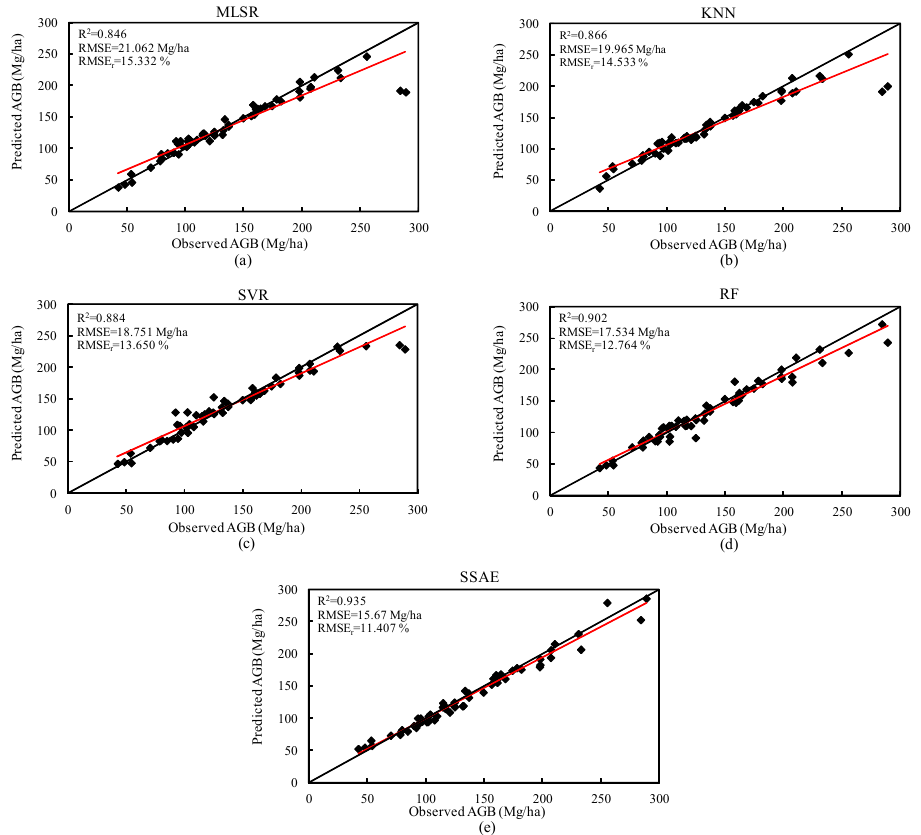
Figure 4. Comparisons between field observations and model predictions derived from the combination of ACOLI1, AO and AL for the five models: ( a ) MSLR, ( b ) KNN, ( c ) SVR, ( d ) RF, ( e ) SSAE. Note: The red and black lines separately denoted the fitted trend-lines and the 1:1 line.